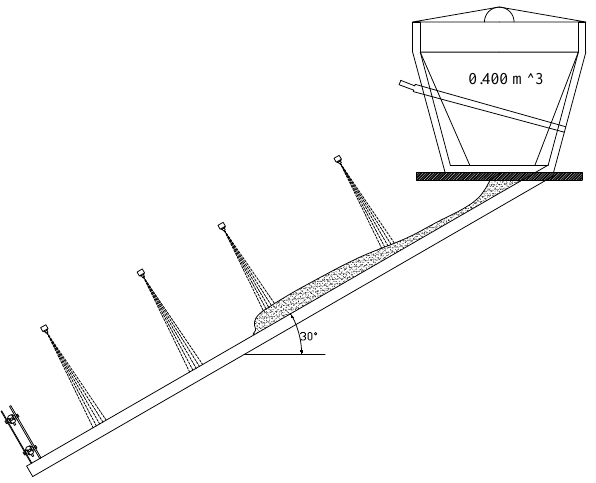
Fig. 1. Schematic representation of the flume. It was possible to install the barrier orthogonal to the bottom, as shown, or in a vertical position.